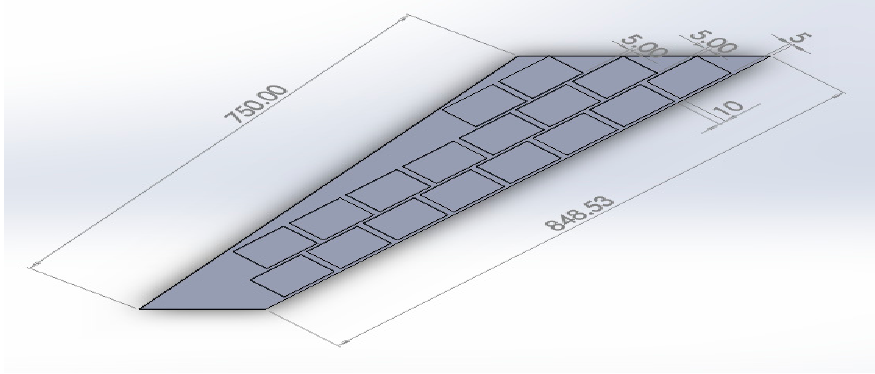
Figure 16. CAD model for a sweptback wing with MFC actuators on its surface (dimensions are in mm).